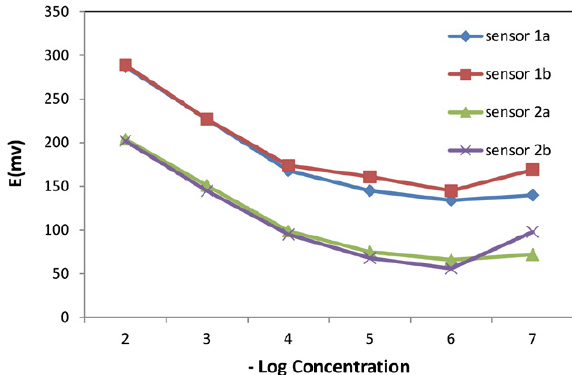
Fig. 2. Profile of the potential in mV versus –log(concentration of Lab) using the investigated